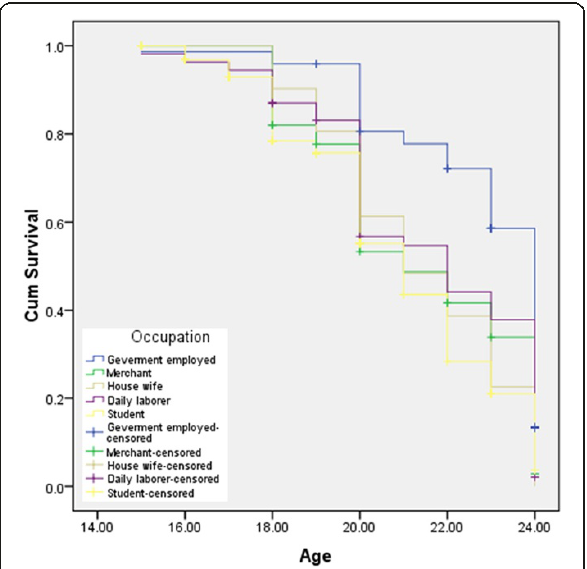
Figure 2 Kaplan-Meier indicating age at sexual initiation among youths with respect to occupation in Gamo-Gofa, South West Ethiopia (Log Rank chi-square = 33.12, p-value =